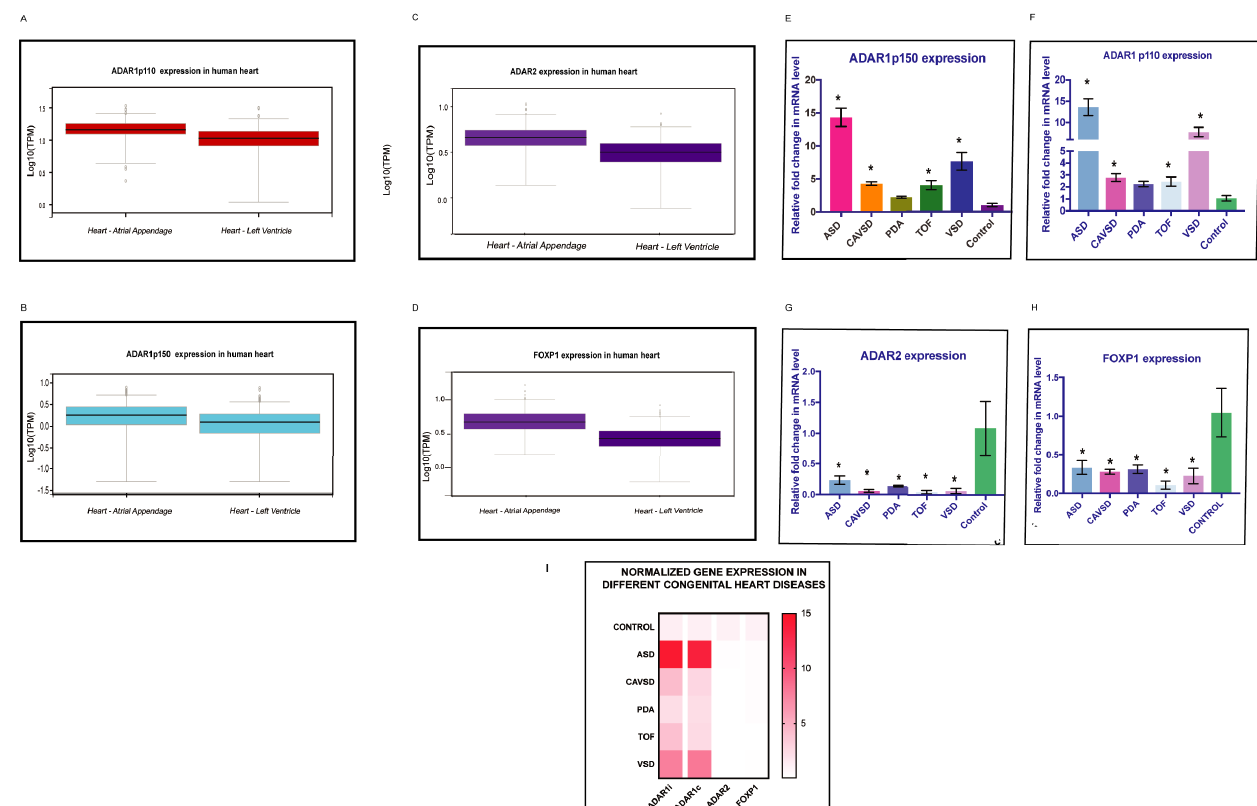
Fig 2. Heart defect-specific function. (A& B) ADAR1 p110 and ADAR1 p150 showed higher expression in the atrial appendage than in the left ventricle. The Y-axis represented the log10 of the transcript per million (TPM) value. The expression of ADAR1 p150 (log 10 TPM 0.5) is lower in heart atrium as compared to ADARp110 (log 10 TPM 1.0). The whiskers represent the maximum and minimum values. The median is represented as a black line in the box. This indicated that ADAR1 isoforms express strongly in the heart atrium as compared to ventricles. (C&D) ADAR2 and FOXP1 showed higher expression in the atrial appendage than in the left ventricle (log 10 TPM 0.7). The expression of ADAR2 and FOXP1 is lower as compared to ADAR1. The whiskers represent the maximum and minimum values. The median is represented as a black line in the box. (E& F) Bar graph showing upregulation of ADAR1 p110 (ADAR1c) and p150 (ADAR1i) in different CHD cases. Both isoforms are significantly upregulated in ASD and VSD. This indicated that both ADAR1 isoforms have potential role in atrial heart tissue. However, a 3- to 4-fold increase in RNA levels was found in AVSD and TOF cases compared to controls. This implies that ADAR1 isoforms are upregulated in response to cardiovascular defects. The PDA cases did not show a significant difference from controls. The error bars indicate the mean +/-SD. � P < 0.05 (versus control), as determined by the Mann–Whitney U test. (G) Bar graph showing a strong decline in ADAR2 expression, particularly in AVSD, TOF and VSD, in CHD cases compared to controls. This indicated that ADAR2 might have a potential role in both heart atrium and ventricular tissue. ADAR2 is significantly downregulated in all CHD cases. Error bars indicate the mean +/-SD. � P < 0.05 (versus control), as determined by the Mann–Whitney U test. (H). Bar graph showing reduced expression of FOXP1 in all CHD cases signifying its importance in cardiovascular development. The strongest decrease was observed in the TOF samples. � P < 0.05 (versus control), as determined by the Mann–Whitney U test. The error bars indicate the mean +/-SD. (I). Heat map showing the normalized expression levels of ADAR1 p150 (ADAR1i), ADAR1 p110 (ADAR1c), ADAR2 and FOXP1 in different CHD cases compared to controls. The expression values are normalized with the housekeeping gene TUB1. The red color indicates increase in expression whereas the lighter red represents decrease in expression as compared to